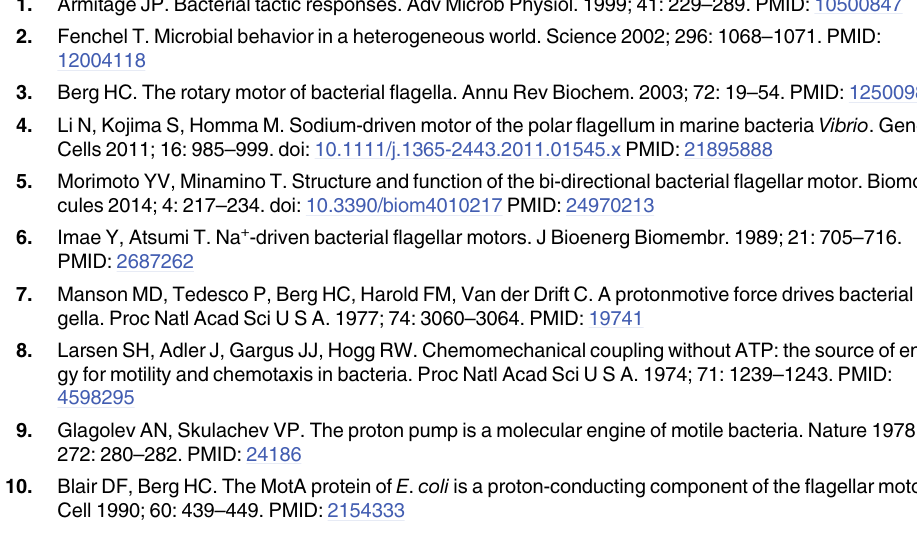
- S4 Table. Statistical analyses of tracks from V . cholerae Δ pomAB cells overproducing His 6 PomA together with PomB-Strep, PomB-S26A-Strep or PomB-S26T-Strep in LB medium with 171 mM K + added. At pH 7.0, 8.0 and 9.0, the total numbers of tracks recorded with -PomA and wild type PomB-Strep were 649, 631 and 650, V . cholerae Δ pomAB expressing His 6 -PomA together with PomB-S26A-Strep, the numbers of tracks were 640, respectively. For His 6 659 and 650, respectively, and 650, 650 and 650 for His -PomA together with PomB-S26T- 6 Strep. SD: Standard